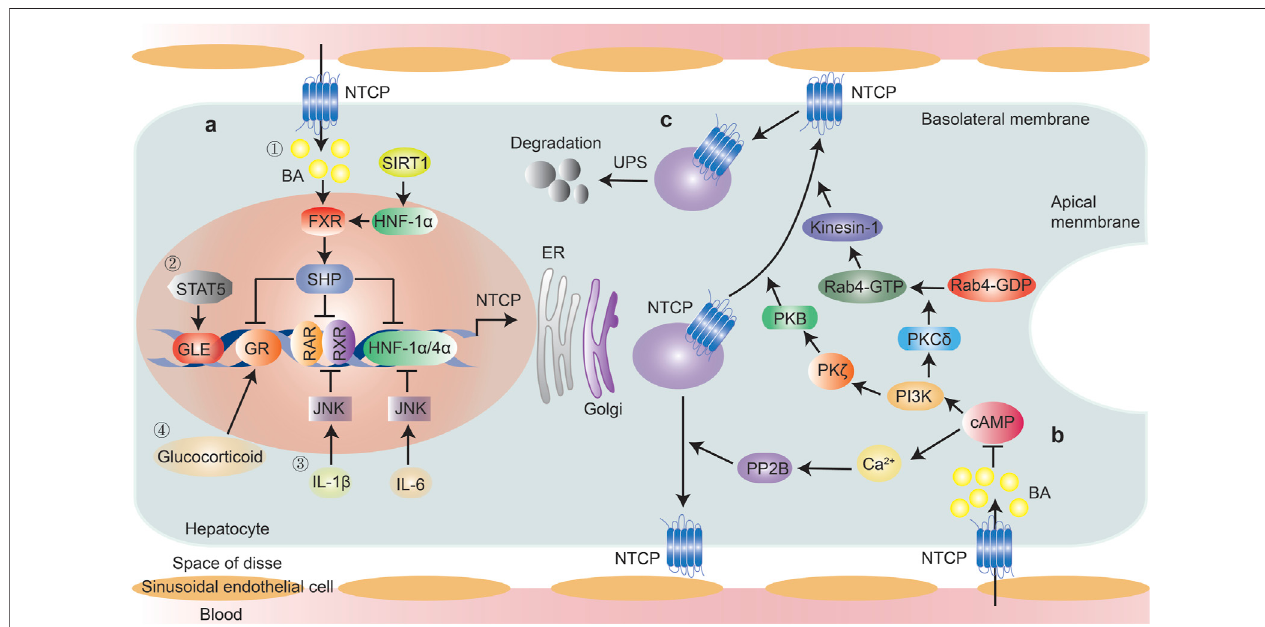
FIGURE 2 | Regulation of NTCP expression. Transcriptional and post-translational regulation of NTCP were summarized. (A) Transcriptional regulation, ① Bile acid-induced, FXR-mediated induction of the nuclear repressor SHP is a key mechanism reducing NTCP expression, through its interference with the RXR-RAR heterodimer,HNF-1 α andHNF-4 α ,whichhavebindingsiteswithintheNTCPpromoter.FXRexpressioncanbemodulatedbySIRT1throughHNF-1 α ; ② STAT5directly bound to NTCP promoter and mediates NTCP expression; ③ IL-6 down-regulates the expression of NTCP through suppression of HNF1 α and HNF4 α in JNK pathway-dependent manner, IL-1 β down-regulates the expression of NTCP via suppression of the RAR/RXR complex in JNK pathway-dependent manner; ④ GlucocorticoidincreasesNTCPexpressioninaGR-dependentmanner,whichwasinhibitedbyFXR-inducedexpressionofSHP. (B) Post-translationalregulation,PP2B and PI3K/PKB/PKC axis facilitate the intracellular movement of NTCP towards the plasma membrane following cAMP activation. Elevated bile acid levels inhibit cAMP activation; (C) . NTCP protein abundance was controlled by ubiquitin-proteasome system. Abbreviations: BA, bile acid; FXR, farnesoid X receptor; SHP, small heterodimer partner; HNF-1 α , hepatocyte nuclear factor 1 alpha; SIRT1, hepatic sirtuin 1; STAT5, signal transducer and activator of transcription 5; GLE, interferon- gamma (IFN- γ )-activated sequence-like element; GR, glucocorticoid receptor; RXR, retinoid X receptor; RAR, RXR-retinoic acid receptor; PP2B, protein phosphatase 2B; UPS, ubiquitin-proteasome